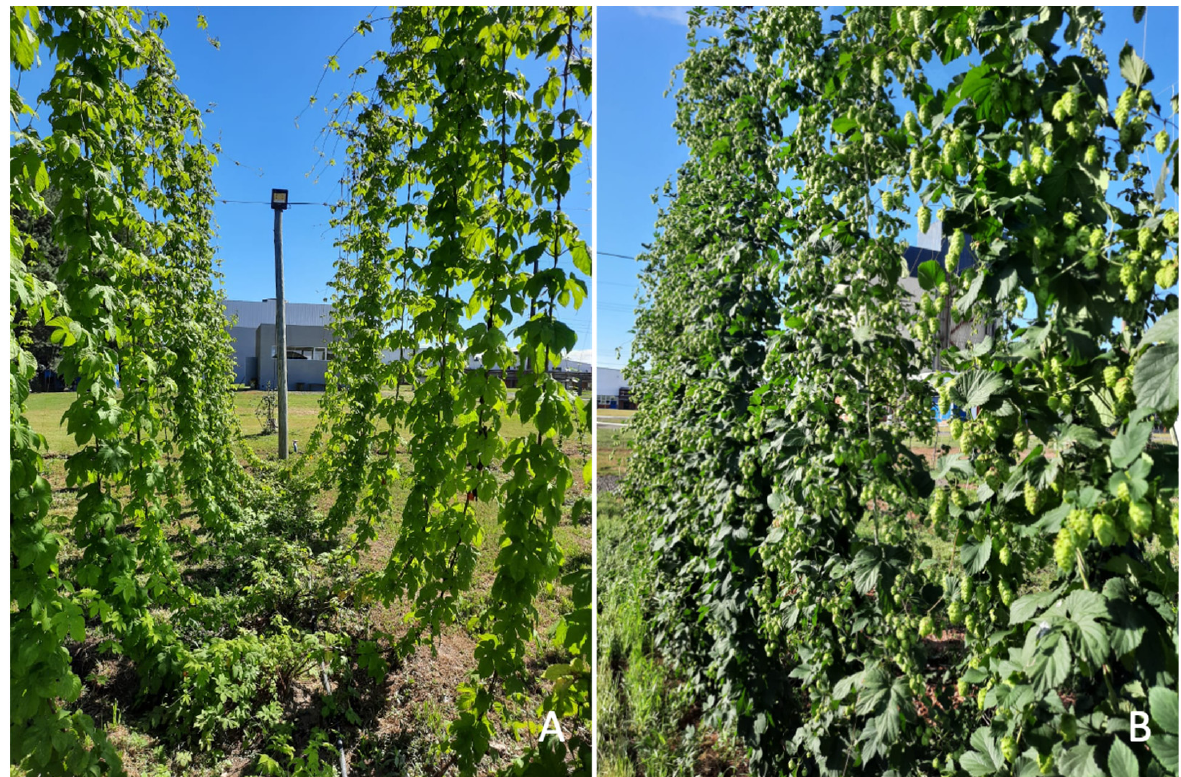
Figure 3. Hops growing in Lages, Santa Catarina state, southern Brazil. ( A ) High trellis training system with bines reaching the top; ( B ) hops with mature cones at harvest.